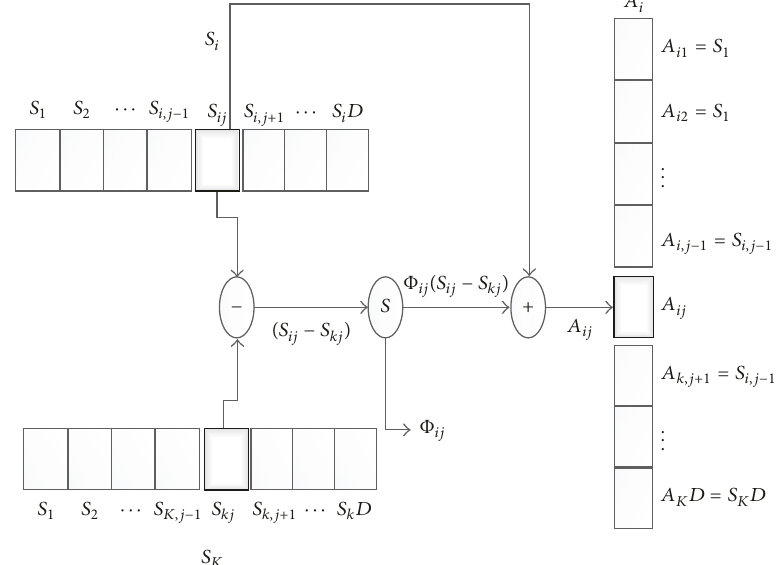
Figure 2: An example of the base station’s position update.